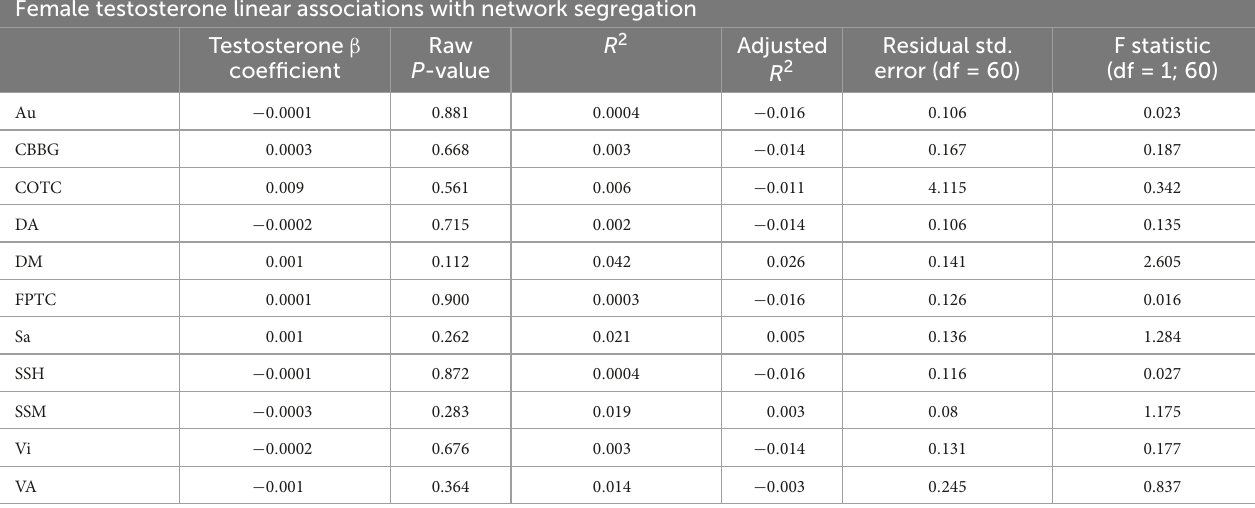
Raw p -valuesandFDRcorrected p -valuesareincluded.TherewerenosignificantfindingsafterFDRcorrection. TABLE 4 This table presents results from linear regressions for testosterone and network segregation in females. Female testosterone linear associations with network